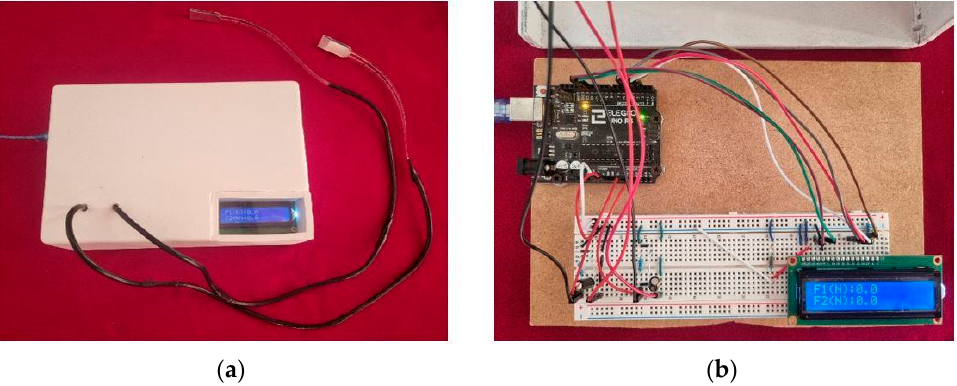
Figure 3. ( a ) External view of the gnathodynamometer with piezoresistive sensors. ( b ) Gnathodynamometer’s electronics.